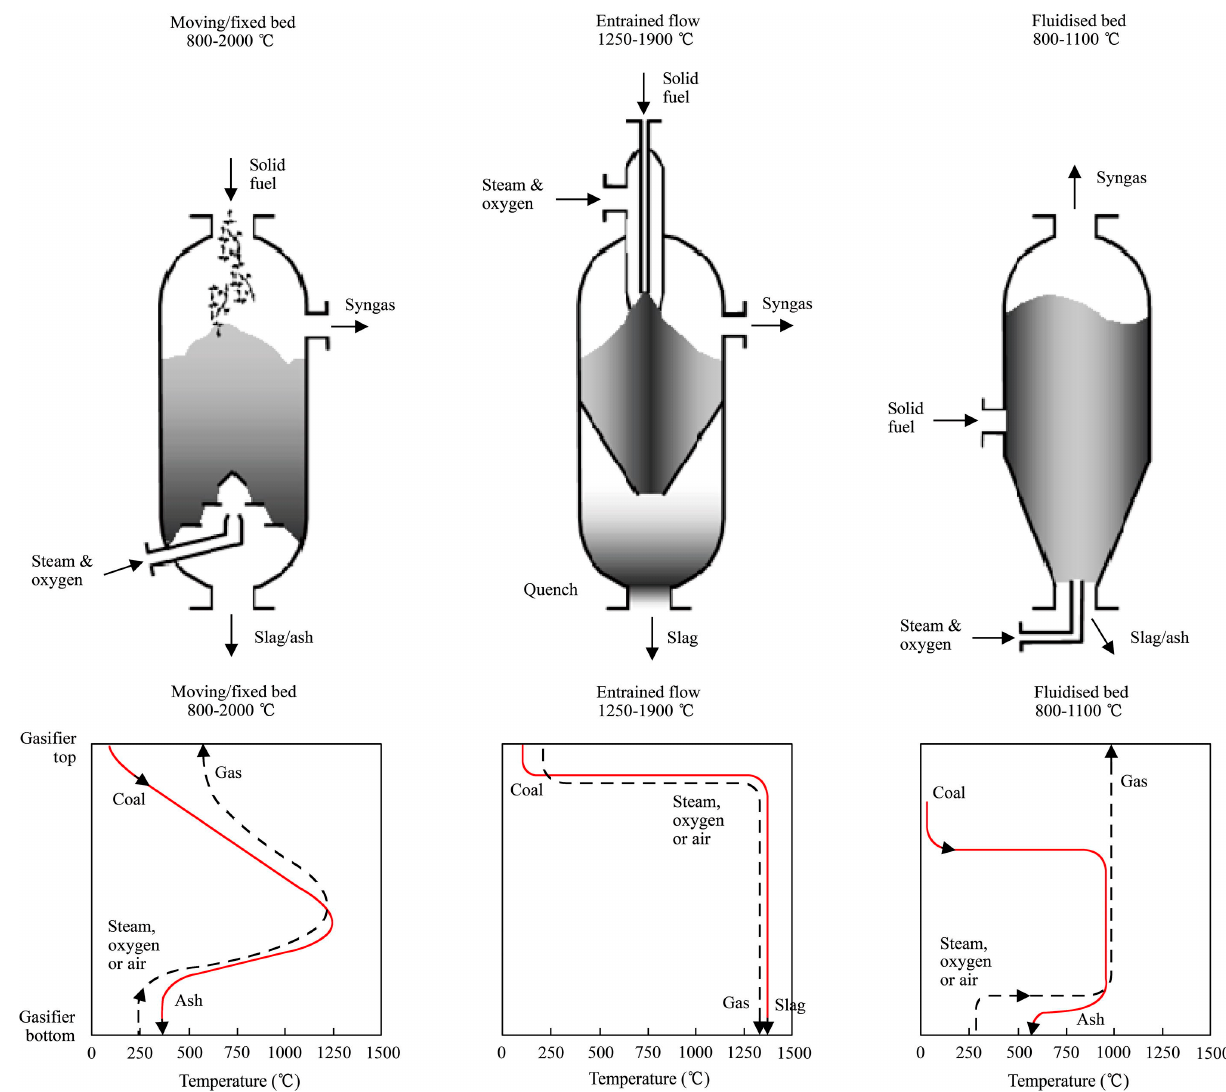
Figure 8. Gasification techniques for brown and black hydrogen production with coal gasification [32].